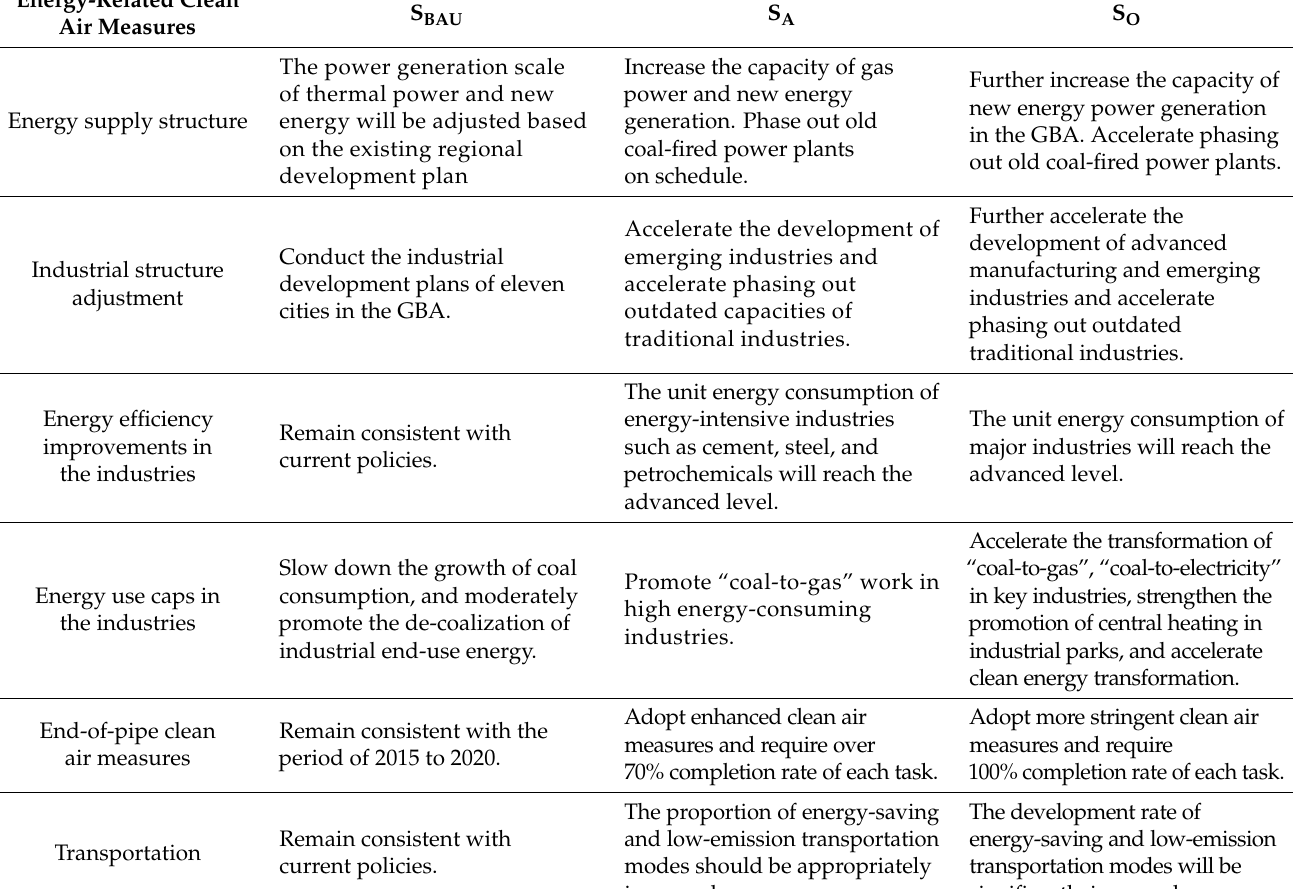
Table 1. Description of